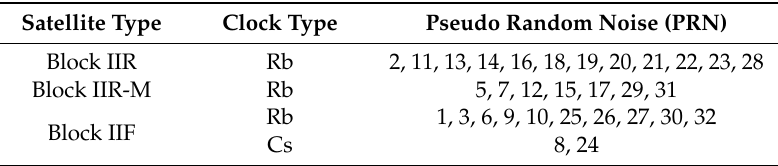
Table 2. The type of satellite and atomic clock on 1 May